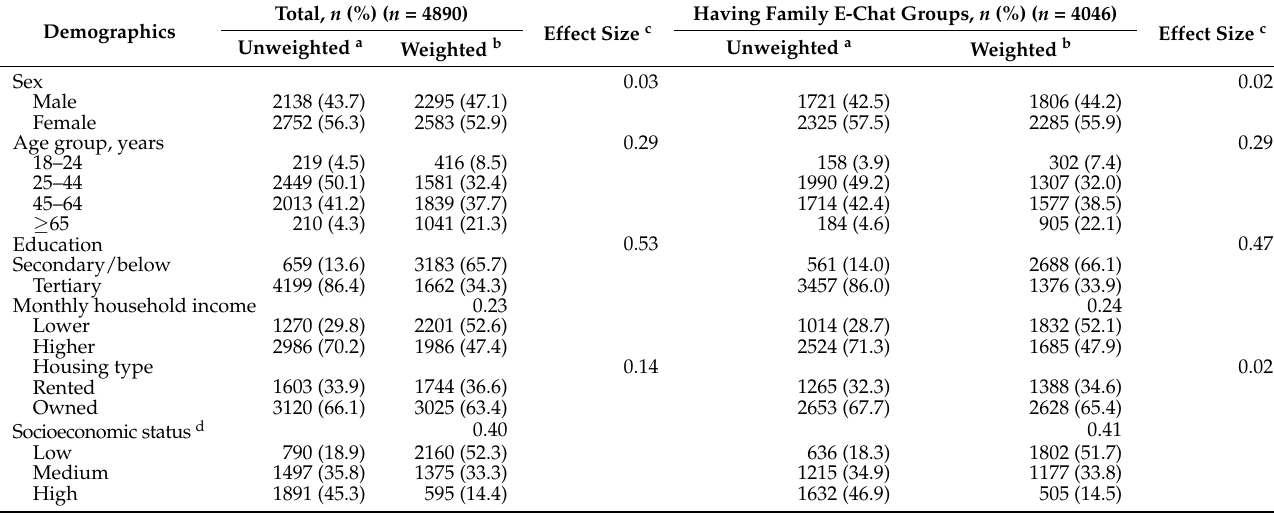
Table 1. Prevalence of having family e-chat groups by sociodemographic characteristics of respondents, n (%).